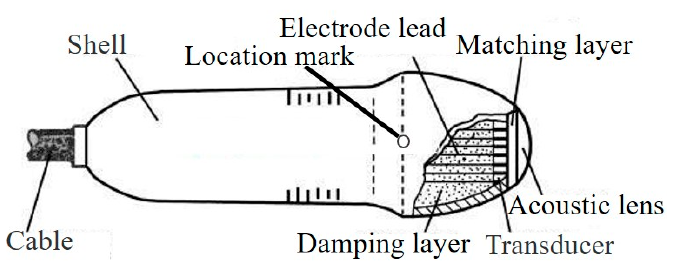
Figure 3. Medical ultrasonic